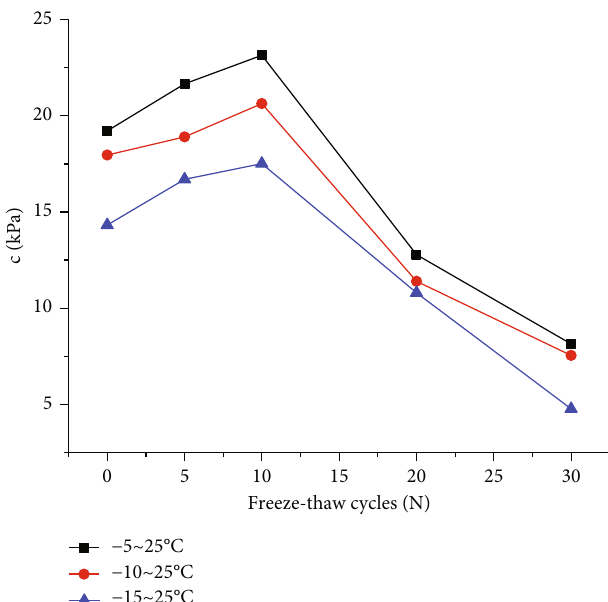
Figure 11: Relationship between freeze-thaw cycles and cohesion.